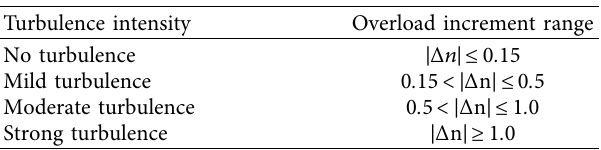
Figure 14: Schematic diagram of height variation of wake vortex before CRJ900 crossing. (a) Height change of maximum washing force. (b) Height change of maximum washing force. Table 11: Classification of turbulence intensity corresponding to overload increment.